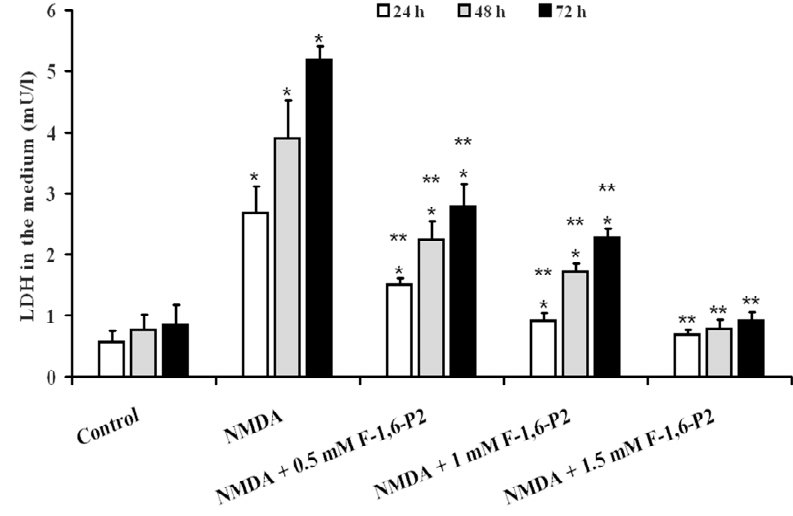
Figure 1. Protective e ff ects of F-1,6-P2 on cell necrosis in NMDA-treated OHSC. OHSC were challenged with 30 µ M NMDA for 3 h and then incubated without and with increasing concentrations of F-1,6-P2 (0.5, 1 and 1.5 mM) for di ff erent times (24, 48 and 72 h). Control OHSC were incubated for the same time intervals, with no prior NMDA treatment or F-1,6-P2 addition. Cell necrosis was deducted by the amount of LDH released in the culture medium and expressed as mU of enzyme activity / L of medium (1 U = 1 µ mol / min of substrate consumed). Histograms are the mean of 6 di ff erent OHSC preparations. Standard deviations are represented by vertical bars. * Significantly di ff erent from corresponding time of control OHSC, p < 0.001. ** Significantly di ff erent from corresponding time of NMDA-challenged OHSC with no F-1,6-P2 supplementation, p < 0.001.